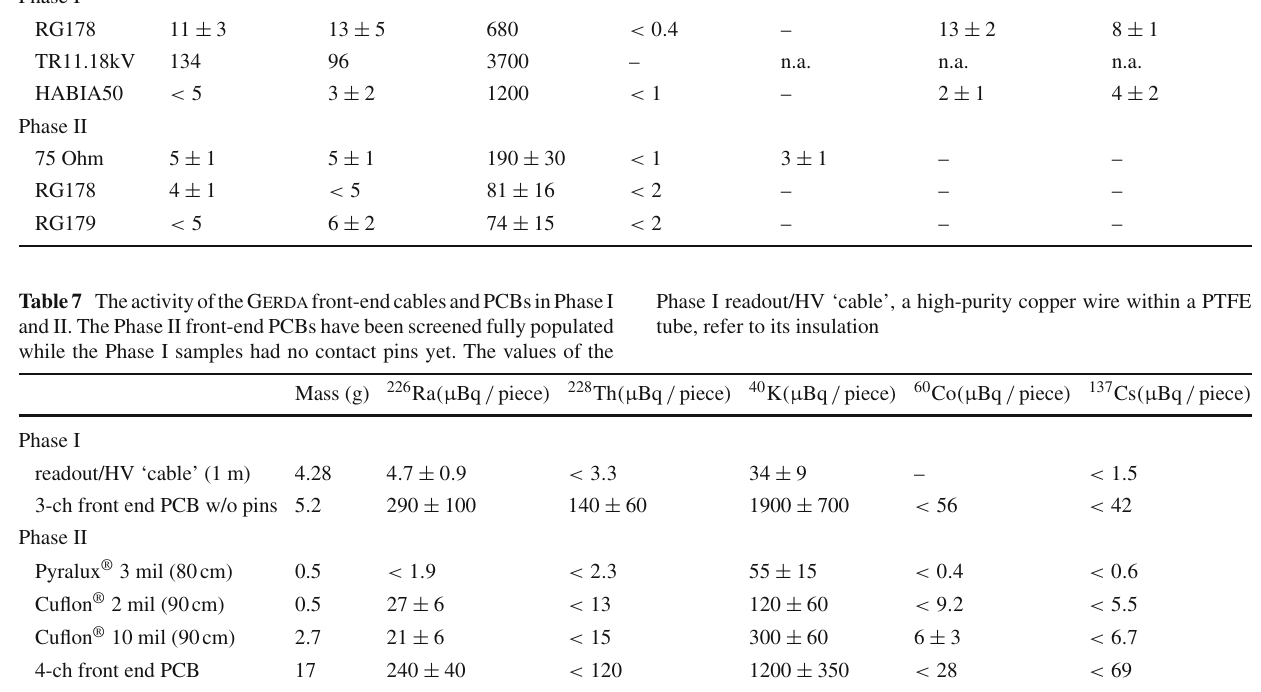
Table 6 The length-specific activities of the custom coaxial cables deployed in Gerda Phase II compared to the standard cables used in Phase I. All screening has been done with Ge γ spectrometers. Phase II cables were woven in bands (see Table 3)